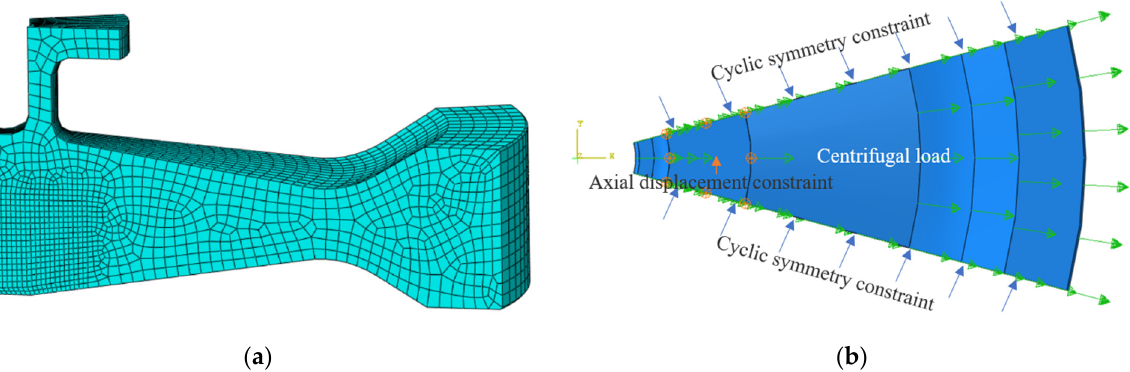
Figure 2. Stress analysis of the disc with the finite element method: ( a ) 3D model and ( b ) load and boundary conditions.